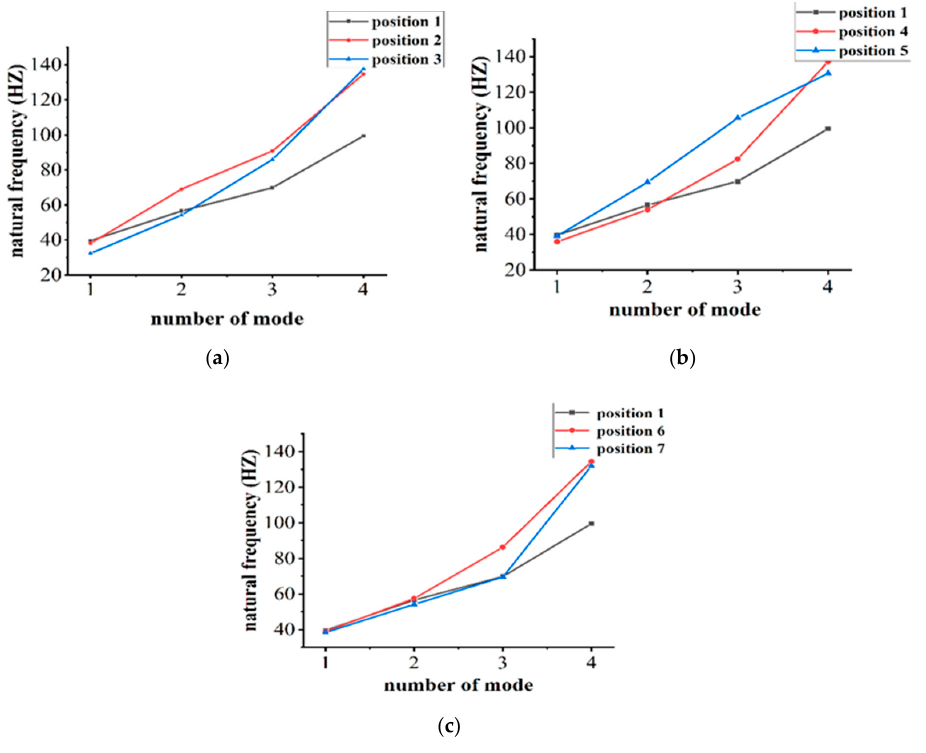
Figure 11. The first 4 order natural frequencies of the PKM in different positions. ( a ) Natural frequency in the x direction; ( b ) Natural frequency in the z direction; ( c ) Natural frequency in the y direction.